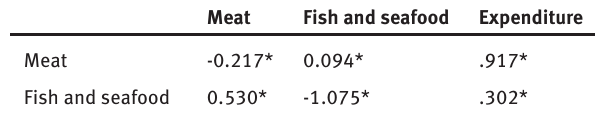
Table 5: Compensated elasticities for aggregate